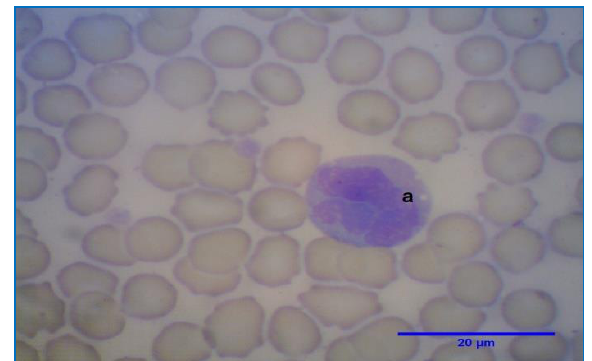
Figure, 7: (a) Large functional Monocyte (100x × 1.3 megapixels).